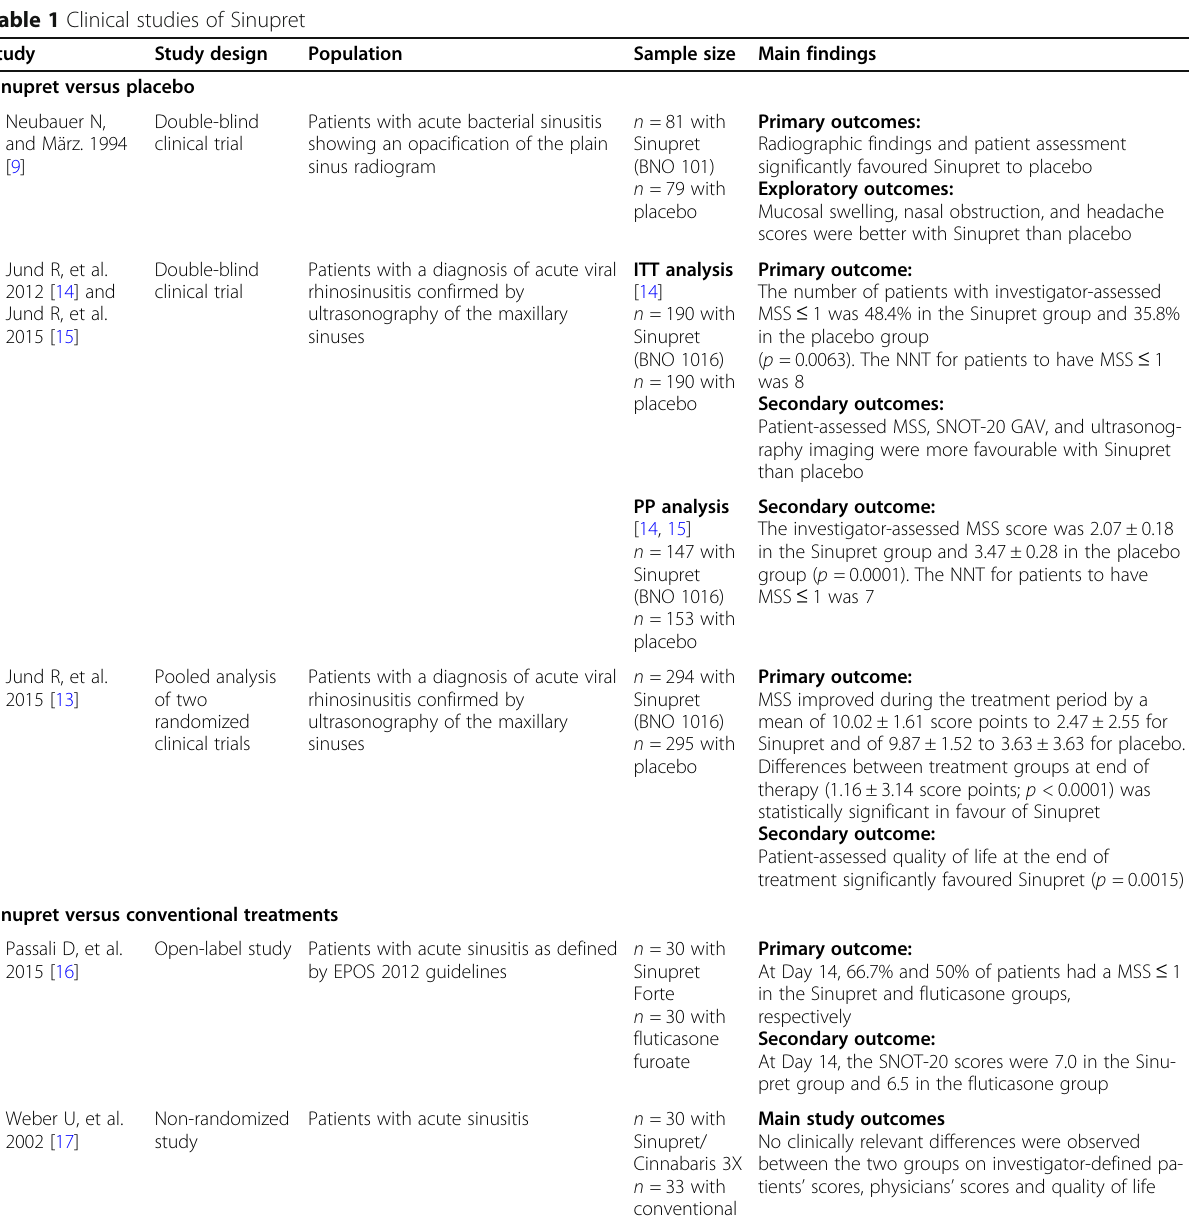
Table 1 Clinical studies of Sinupret